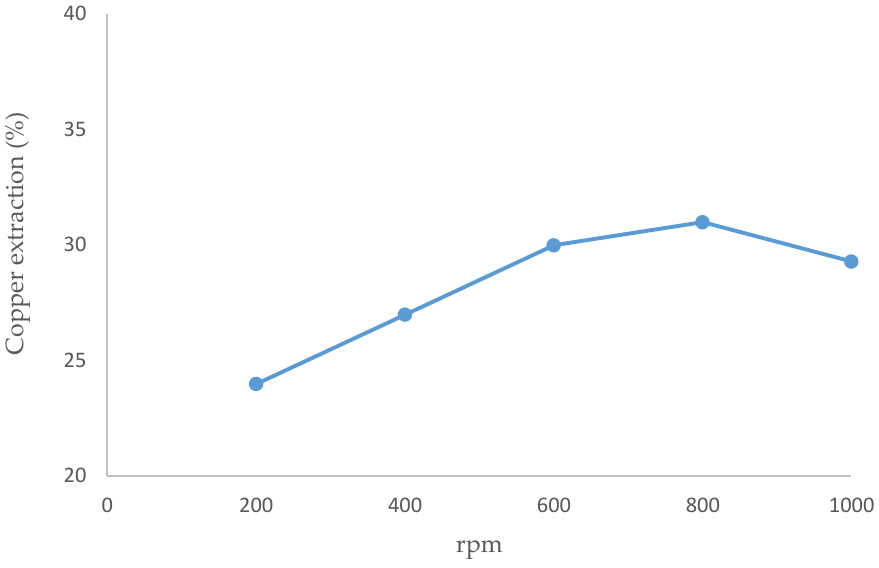
Figure 2. E ff ect of speed stirring on copper dissolution (temperature 80 ◦ C, 20 g / L of Br - , 20% ( v / v ) Figure 2. Effect of speed stirring on copper dissolution (temperature 80 °C, 20 g/L of Br - , 20% ( v / v ) [bmim][HSO 4 ], pulp density 10 g / L, 24 [bmim][HSO 4 ], pulp density 10 g/L, 24 h).